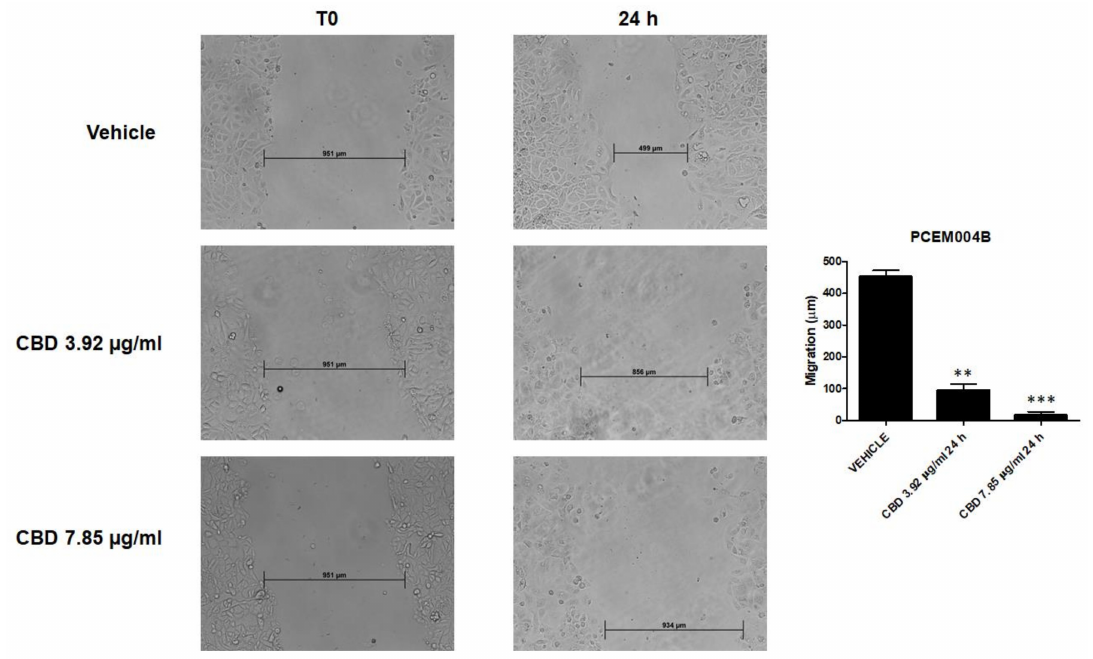
Figure 13. CBD treatment inhibited migration of PCEM004b cells. Wound-healing assays for PCEM004b cells after treatment with CBD 7.85 µ g / mL and 3.92 µ g / mL for 24 h. All experiments were repeated three times and images were taken at 0 and 24 h (20 × ). Data are presented as the mean ± SD. ** p < 0.01, *** p < 0.001 vs.